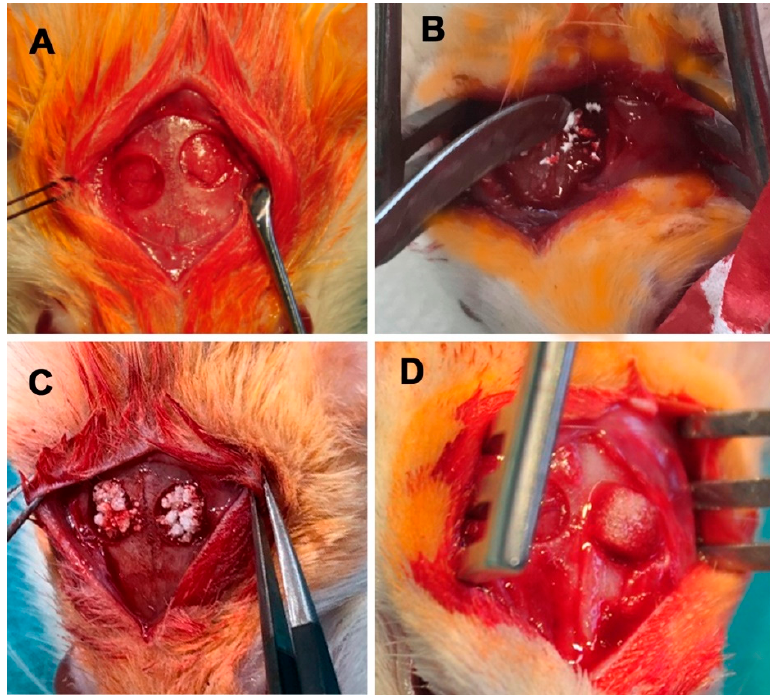
Figure 1. Photograph showing the bilateral critical size-defect with ( A ) empty holes (control group), ( B ) NanoBone ® , ( C ) Actifuse, and ( D ) pre-soaked